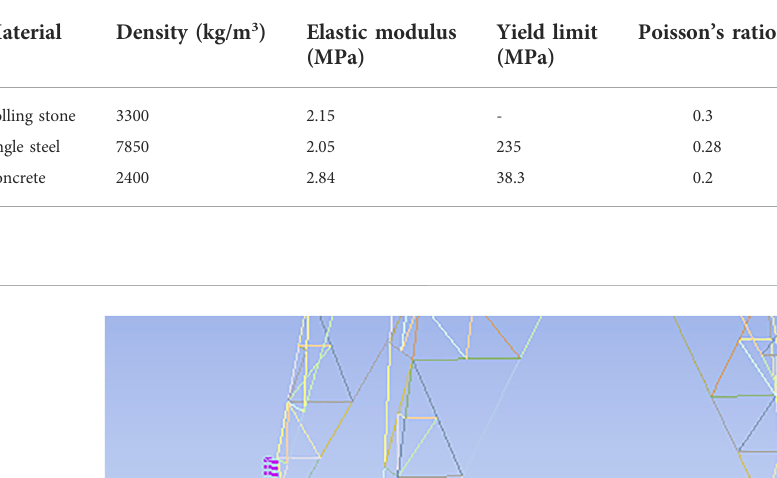
TABLE 1 Material parameters of the rolling stone impact tower.